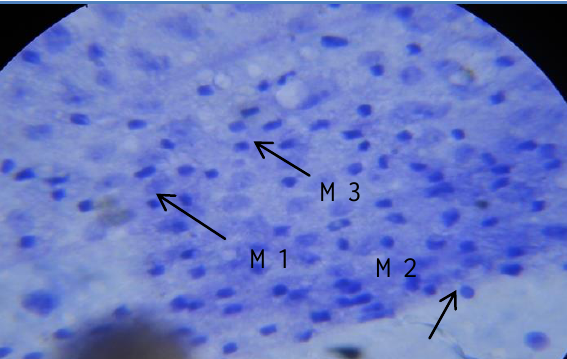
Figure, 2: Chick embryo cells treated In-ovo with 20µg levofloxacin after 3 days of incubation (observe M1, M2 and M3 stages of mitosis) (Hoechest stain 100x under light